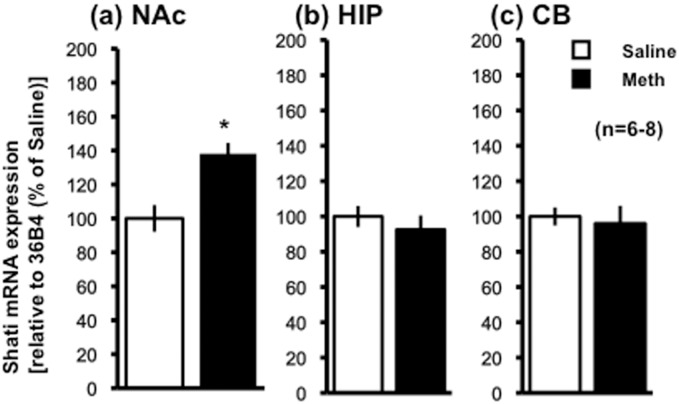
Relative expression of Shati/Nat8l mRNA in mice administered saline or Meth.Real-time RT-PCR was performed to quantify Shati/Nat8l mRNA in mice treated with saline (white bar) or MAP (black bar) from (a) nucleus accumbens (NAc), (b) hippocampus (HIP) and (c) cerebellum (CB). Primers used for each PCR are shown in the text. Data were normalized to 36B4 expression. The fold-change in expression of Shati/Nat8l mRNA was calculated using the ΔΔCT method. Data were plotted as the mean ± SEM. n = 6–8 mice. Significance is set at *p < 0.01.